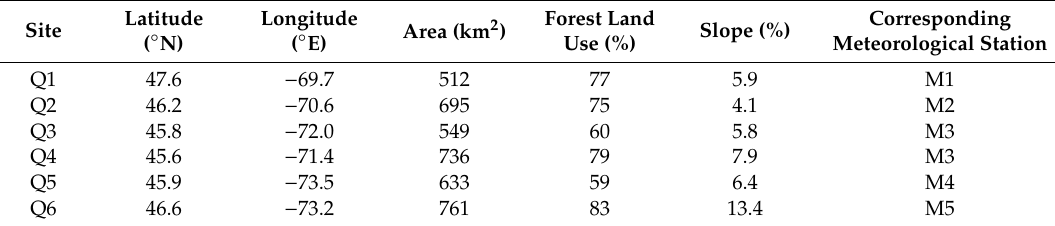
Table 1. Description of hydrometric